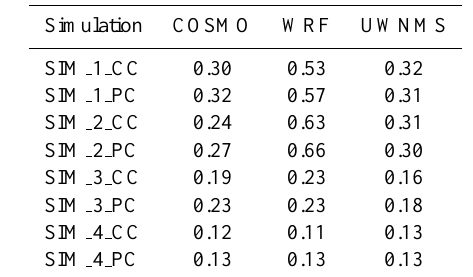
Table 5. Inter-model comparison of the spillover for the set of sim- ulations in Table 2. The spillover is defined as the ratio of leeward precipitation to total precipitation.